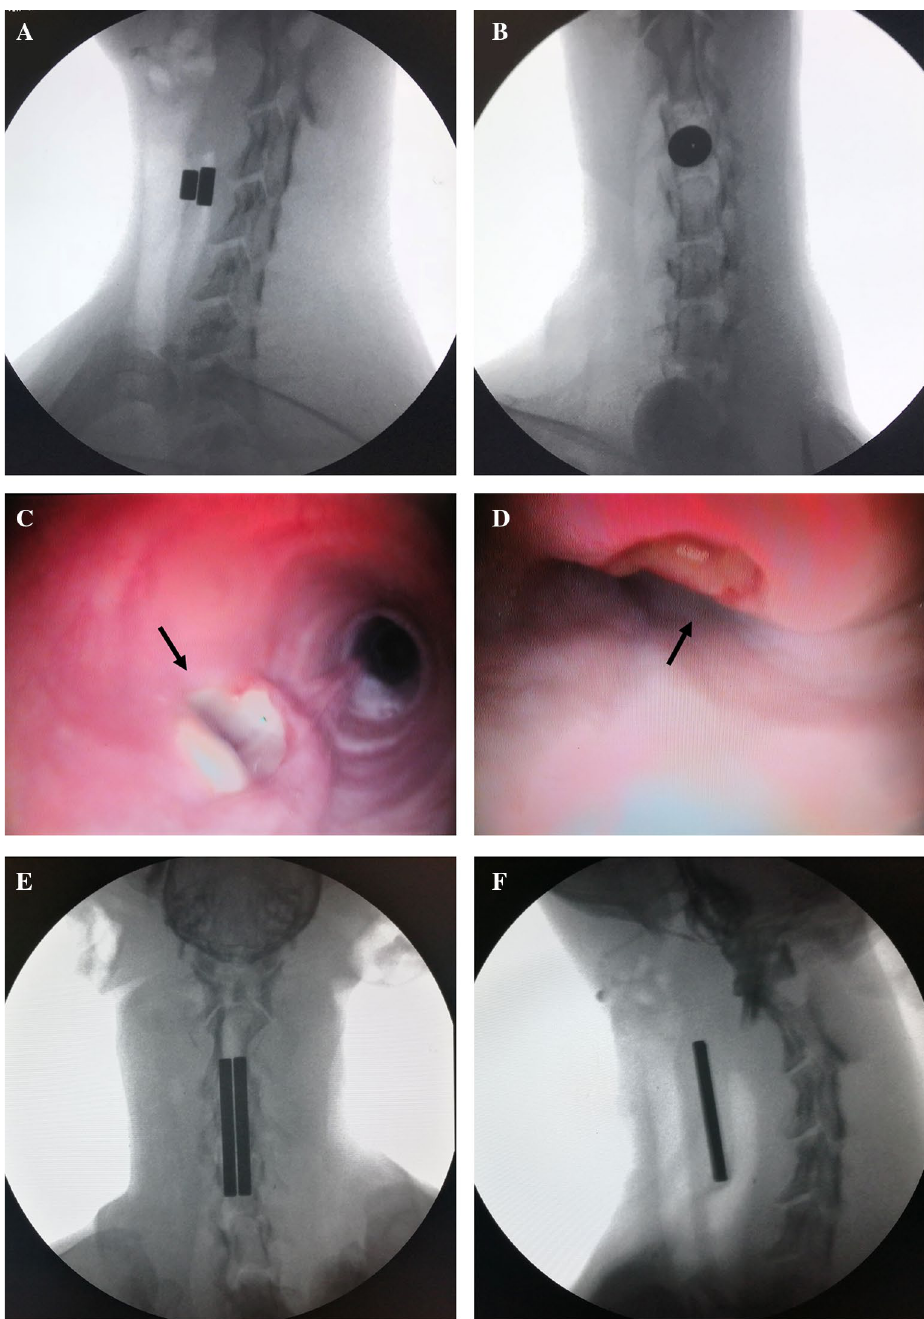
Figure 2. TEF modeling and surgical repair. ( A,B ) Construction of the TEF model—esophagus and trachea magnets attracted each other. ( C ) Bronchoscopy showed TEF in the tracheal membrane. ( D ) Esophagoscopy revealed a fistula in the anterior wall of the esophagus. ( E,F ) The magnets are attracted to each other tightly, squeezing and clamping the TEF without damaging other tissue